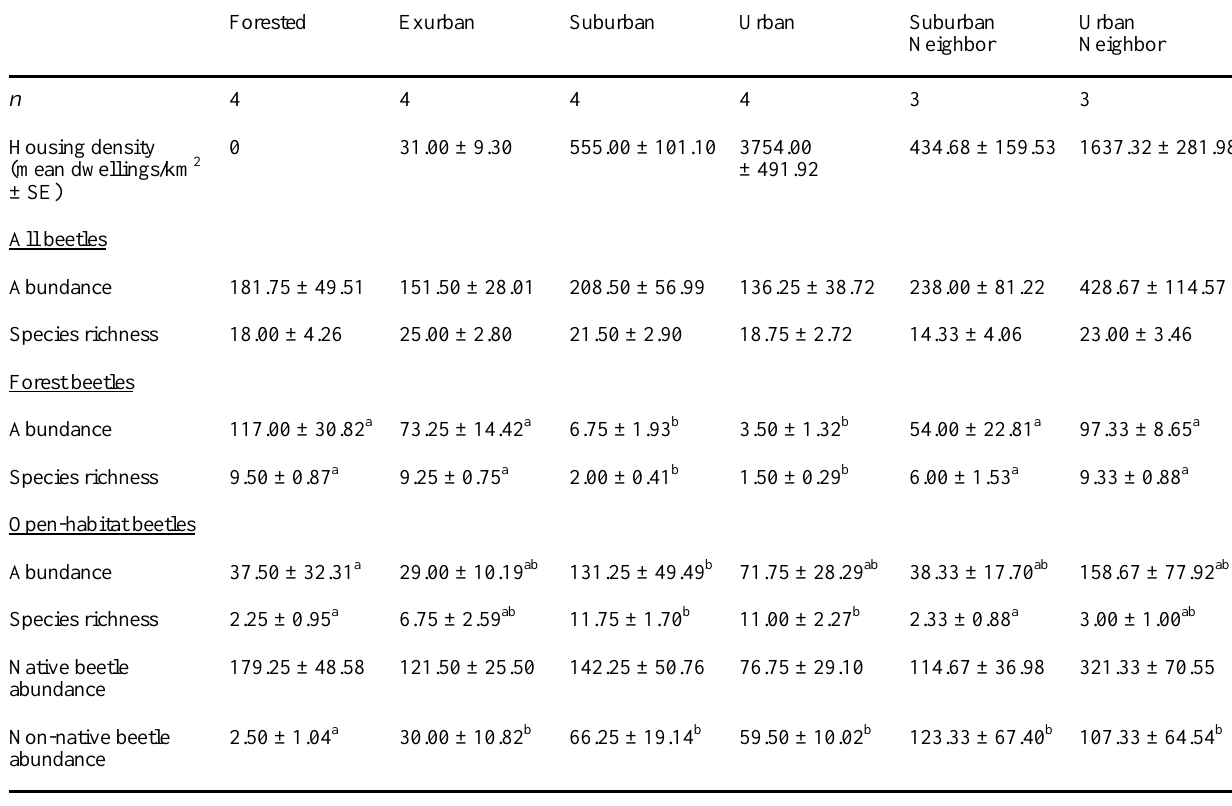
Table 1. Carabid beetle abundance and species richness (mean ± SE) at 500 × 500 m beetle survey sites in six housing categories (see Methods for category definitions). The species included in each group are given in Appendix 2. Different lowercase letters indicate significant pairwise differences between categories for those response variables for which housing category had a significant effect in single-factor